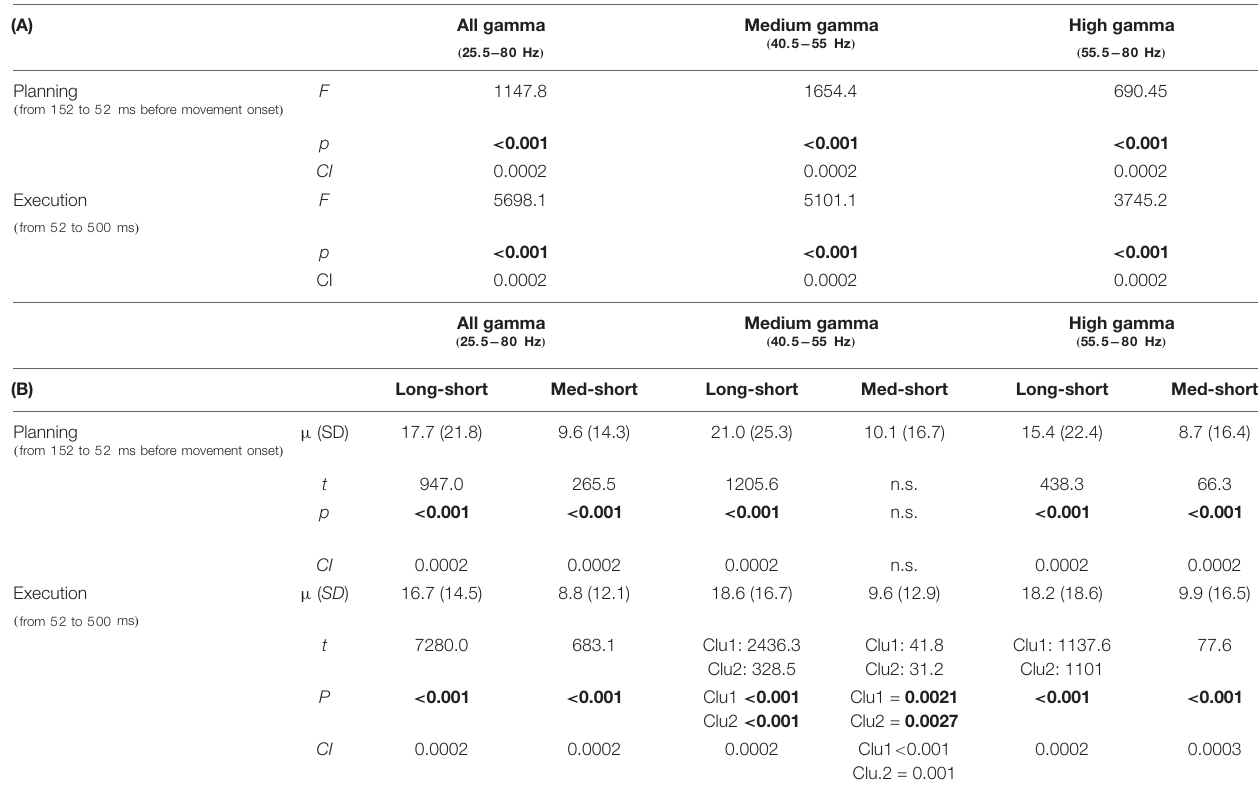
TABLE 1 | Non-parametric Monte Carlo permutation analysis F statistics (A) and post-hoc tests (B) with cluster correction on the difference in gamma amplitude between Short, Medium and Long target distance trials.